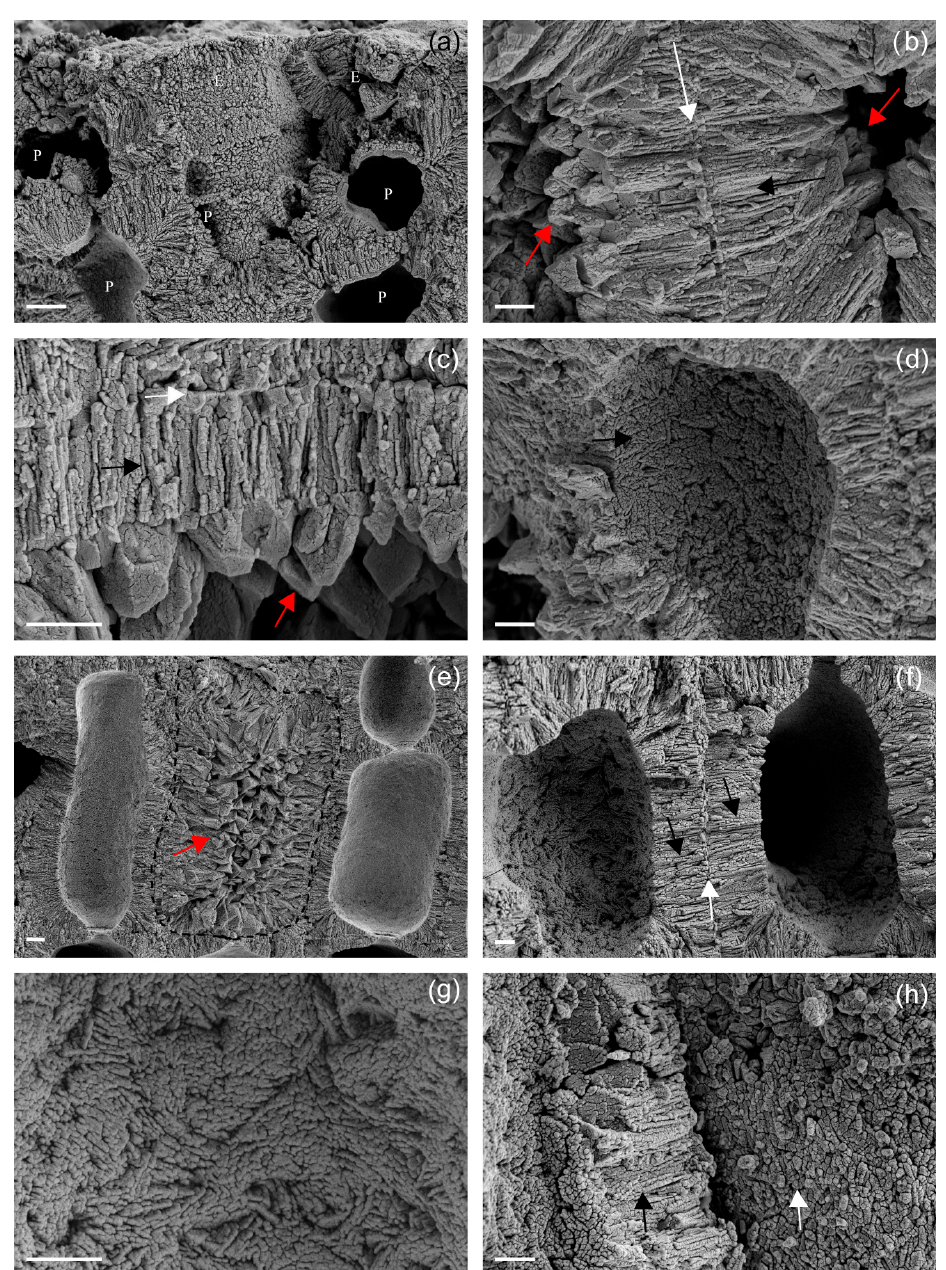
Figure 8. Details of the main ultrastructures of Lithothamnion valens (a–d) and Lithothamnion minervae (e–h) . (a) Perithallial (P) and epithallial (E) cells showing both PW and SW. Scale bar = 2µm. (b) Details of PW (white arrow) and SW (black arrow) of two adjacent perithallial cells. The secondary wall is characterized by elongated radial crystals, whereas PW crystals are tangential to the cell lumen. The cell lumen is filled by secondary calcite (dogtooth shape, red arrows). Scale bar = 1µm. (c) Detail of a cell wall with evident PW (white arrow) and SW (black arrow), as well as secondary dogtooth calcite filling the cell lumen (red arrow). Scale bar = 2µm. (d) Detail of SW (black arrow) as visible in the cell lumen with no membrane. Note the multi-directional arrangement of calcite crystals. Scale bar = 2µm. (e) Perithallial cells with elongated and rectangular shape. The central cell (dashed) shows a cell lumen filled by secondary calcite with dogtooth shape (red arrow). Scale bar = 2µm. (f) Perithallial cells with both PW (white arrow) and SW (black arrows). Note in the cell lumen that the SW is characterized by elongated crystals showing a multi-directional arrangement. Scale bar = 2µm. (g) Detail of the cell lumen with no membrane, showing multi-directional arrangement of elongated crystals in the SW. Scale bar = 1µm. (h) The fracture shows detail of crystals composing the PW (white arrow) apparently composed of granules. The SW is characterized by elongated crystals in longitudinal section (black arrow). Scale bar =